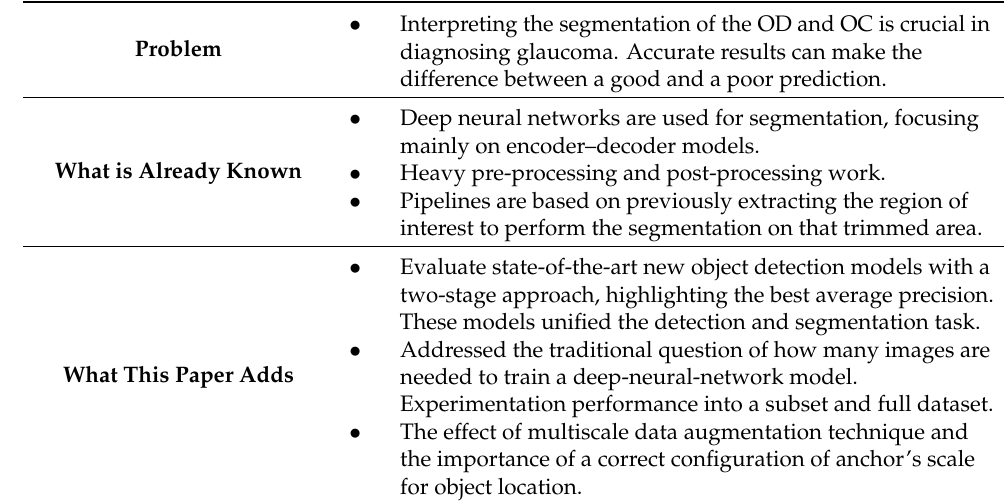
Table 1. Statement of significance of this